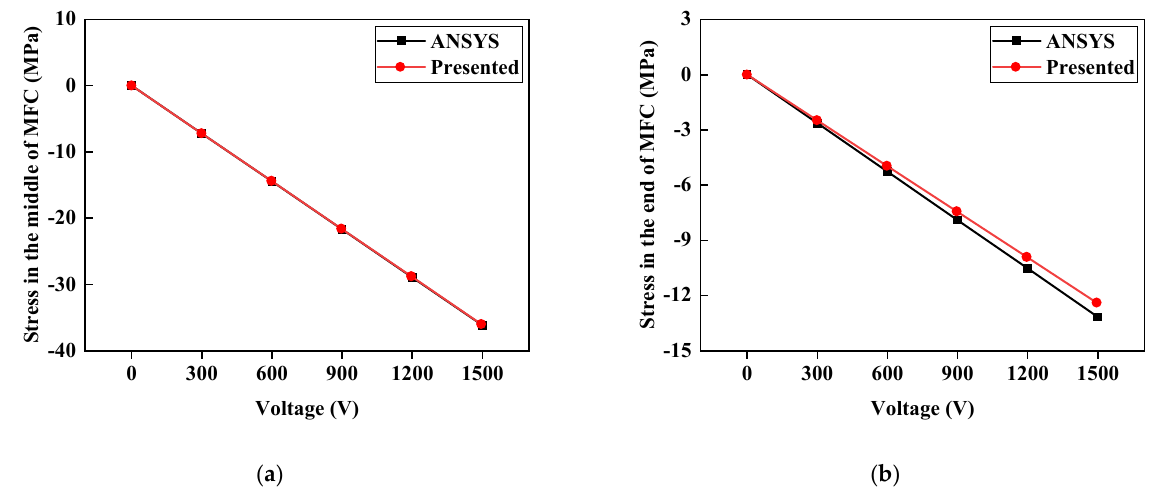
Figure 5. Relationship between voltage and stress in the MFC: ( a ) Stress in the middle of the MFC; ( b ) stress at the end of the MFC. ( b ) stress at the end of the